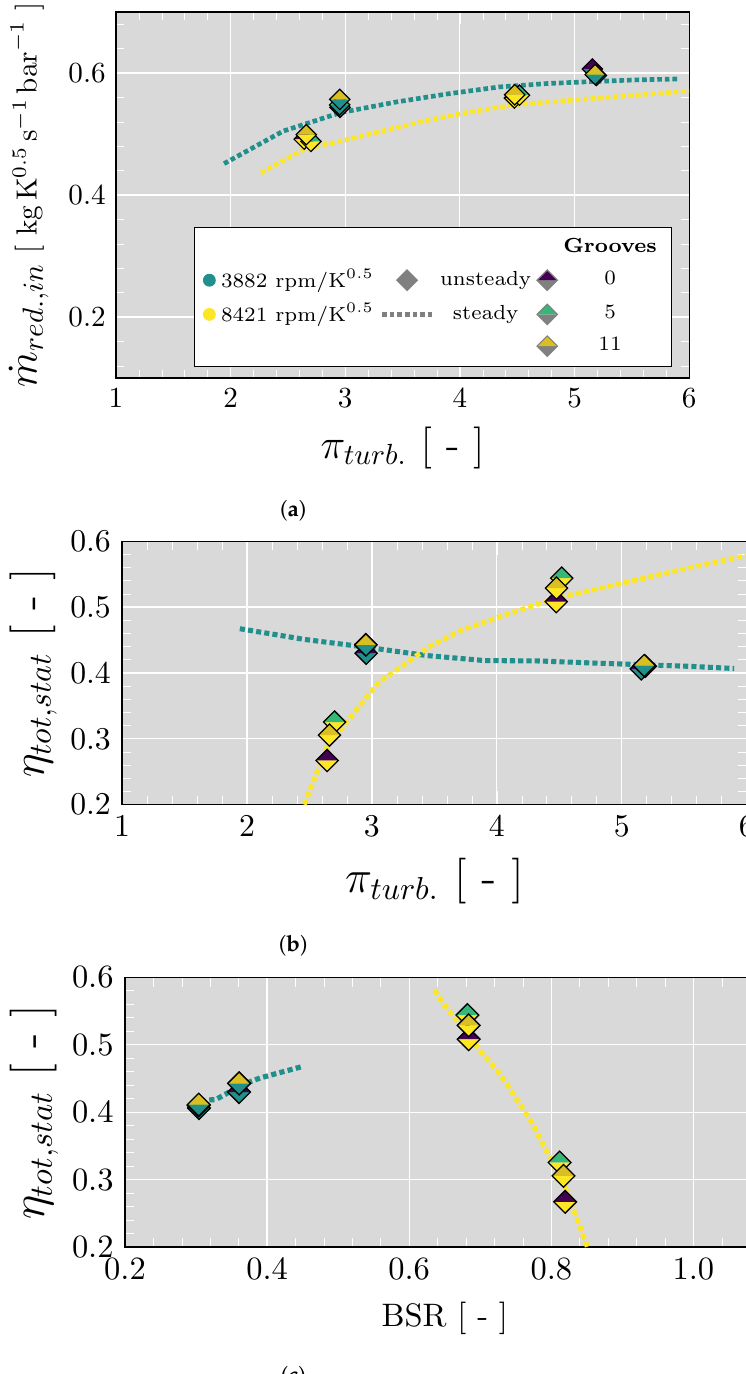
Figure 8. Turbine map based on steady results of the original stator geometry (0 grooves) and unsteady results with and without grooved surface; Steady: Dashed lines; Unsteady: Markers. ( a ) Reduced mass flow map. ( b ) Efficiency vs. expansion ratio map. ( c ) Efficiency vs. blade-speed- ratio (BSR)